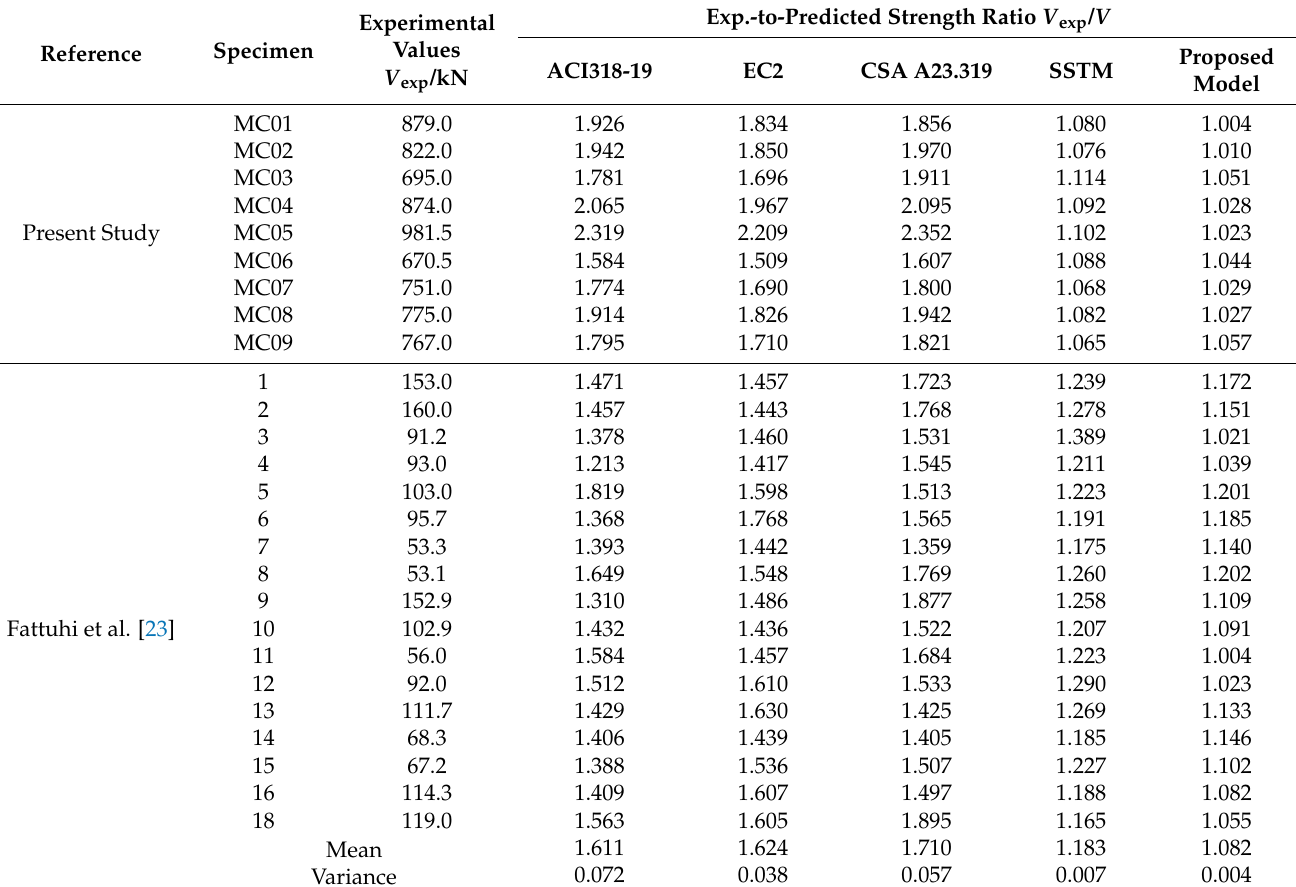
Table 5. Comparisons of the experimental and calculation